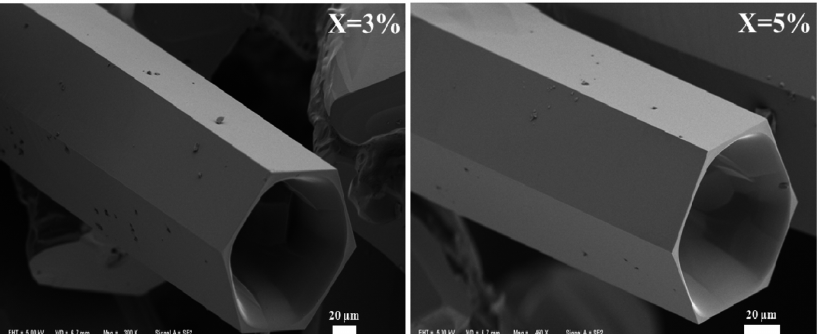
Figure 2: FE-SEM images of the micro- wave synthesized Zn 0.97 Cd 0.03 O and